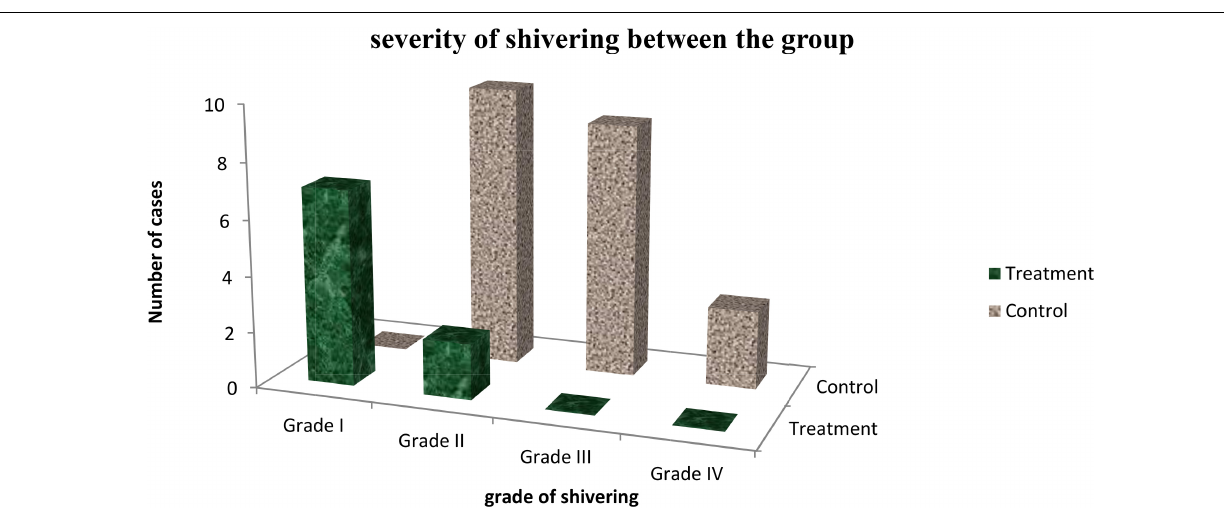
Frontiers in Medicine |